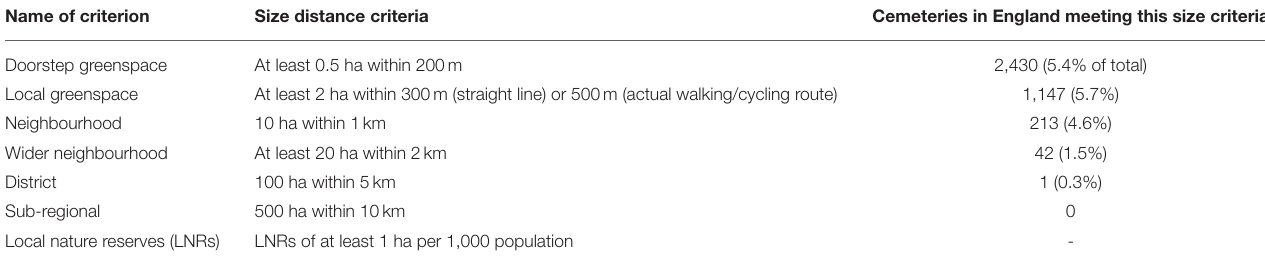
TABLE 1 | Draft updated natural accessible greenspace standards (Houghton,